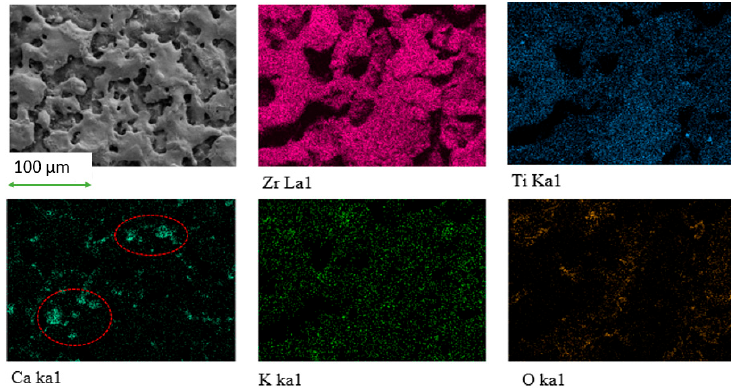
Figure 5. SEM elemental mapping showing the distribution of major Zr 67 Cu 11 Ni 10 Ti 9 Be 3 BMG and HA elements on the HAm-EDMed BMG surface. Encircled in red are deposited and agglomerated Ca element.